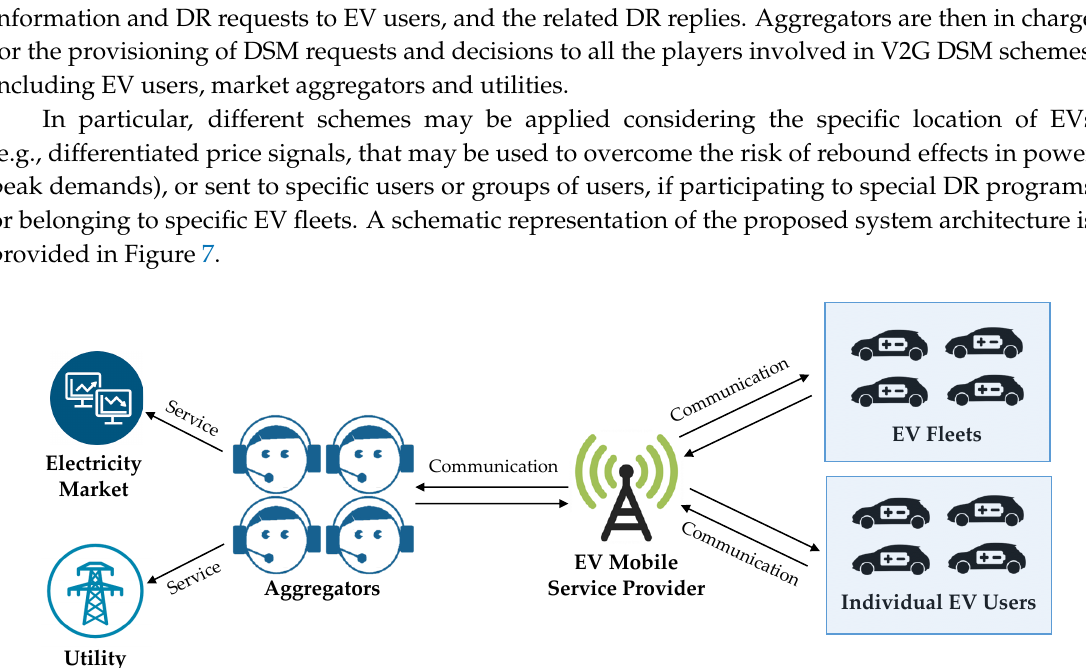
Figure 7. Schematic representation of the proposed system architecture for the provisioning of V2G mobile communication services among aggregators and EV users. EV: Electric